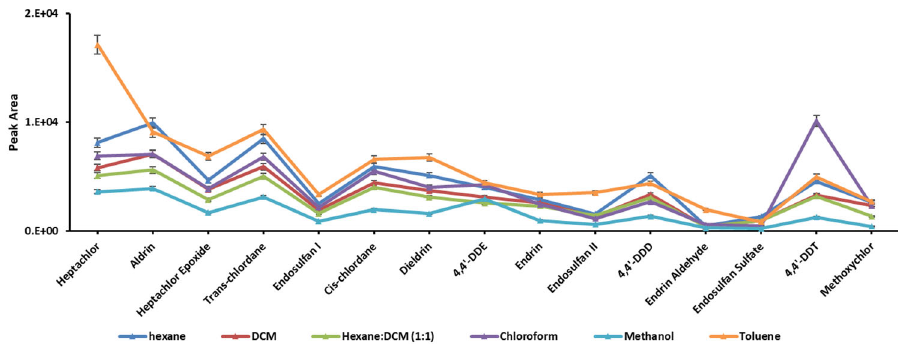
Figure 2. Optimization of type of extraction solvent.